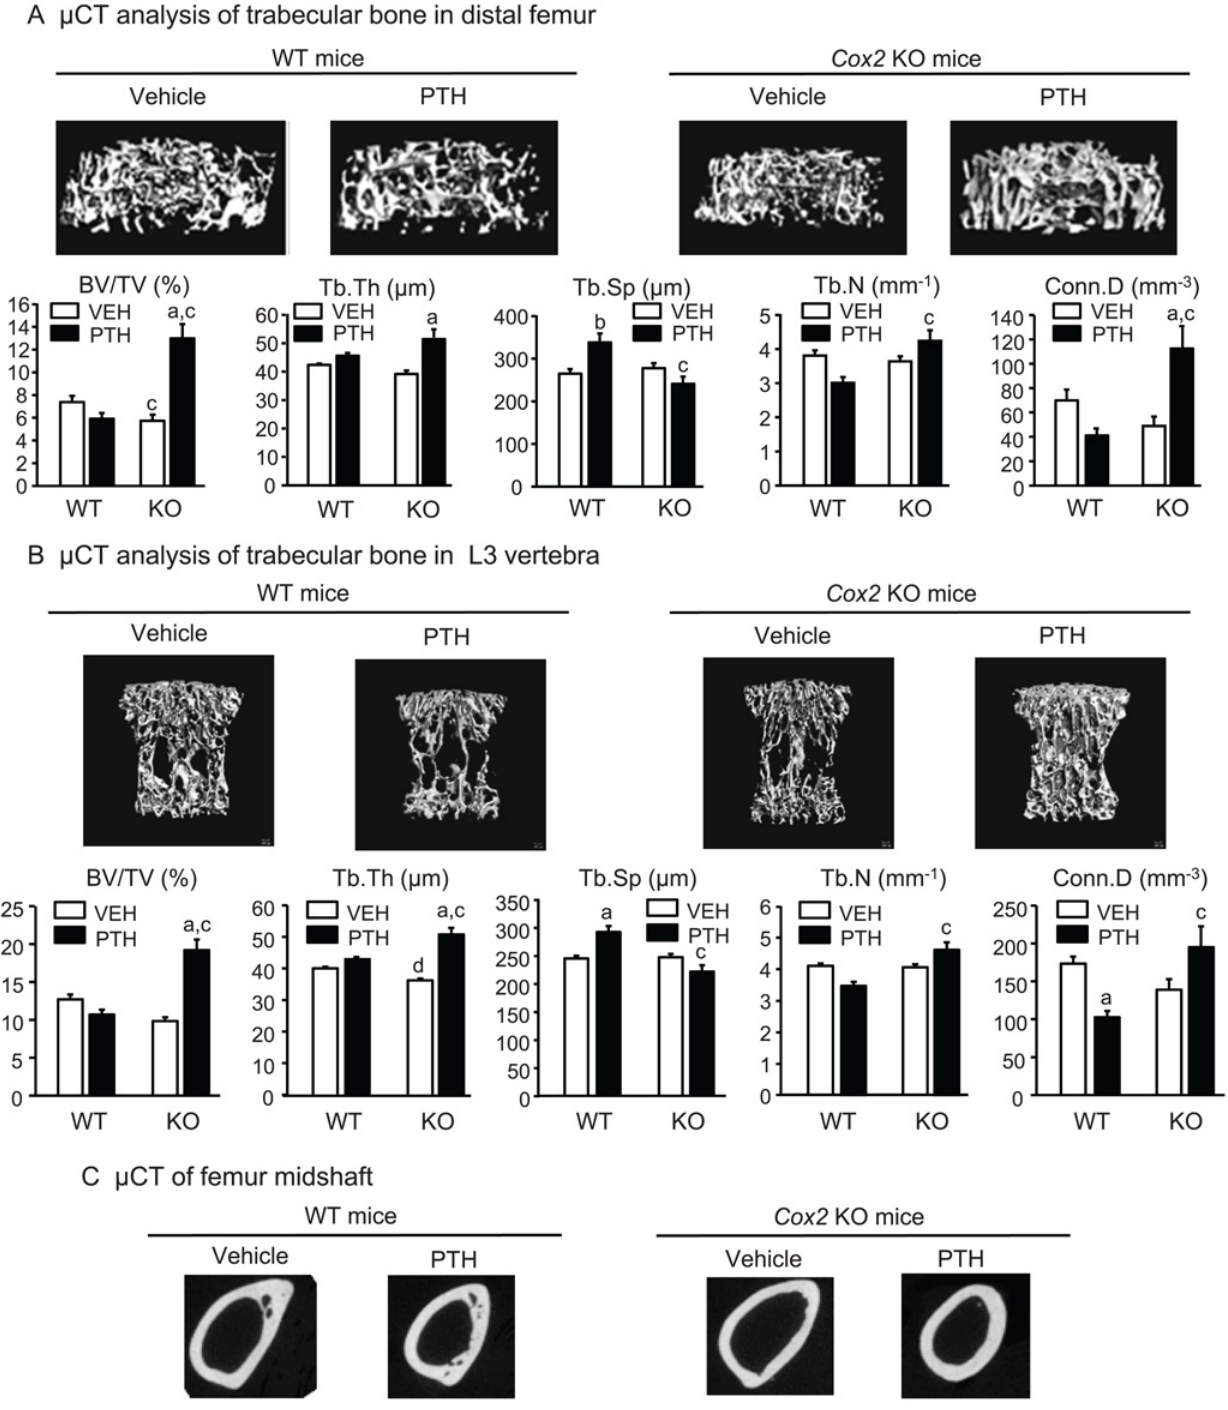
Fig 2. Morphometry of femoral bone and L3 vertebral bone in mice infused for 12 days. A. Representative μ CT longitudinal images (top panel) and morphometric analyses (bottom panel) of trabecular bone in the metaphyseal region of distal femur. Bars are means ± SEM for 7 WT and 7 KO mice treated with vehicle and 8 WT and 8 KO mice treated with PTH. B . Representative μ CT cross-sectional images (top panel) and morphometric analyses (bottom panel) of trabecular bone in the L3 vertebrae. Bars are means ± SEM for 7 WT and 7 KO mice treated with vehicle and 8 WT and 8 KO mice treated with PTH. C . Representative μ CT cross-sectional images of midshaft of femurs. a Significant effect of PTH, p < 0.01; b p < 0.05. c Significant effect of genotype, p < 0.01; d p < 0.05.